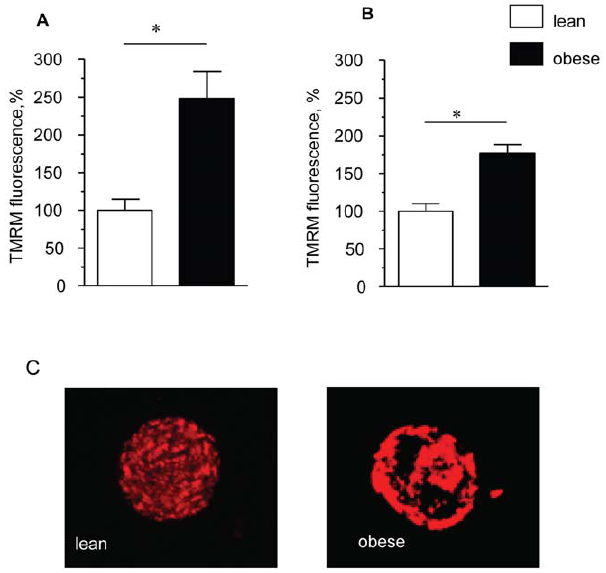
Figure 1. Maternal diet-induced obesity leads to increased mitochondrial activity in the oocytes and zygotes. The measurements of inner mitochondrial membrane potential ( Dy m ) were made using confocal imaging of TMRM fluorescence. The signal intensity was quantified per pixel in a confocal slice after thresholding to remove background signal. (A) – oocytes and (B) zygotes derived from lean (n=15 cells/group) and obese females (n=15 cells/group). Relative intensity of TMRM fluorescence is expressed as a percentage of the signal from oocytes of lean mice. (C) Representative confocal images of mitochondria distribution in oocytes from lean and obese mice. * p , 0.05. Data are mean 6 SEM.